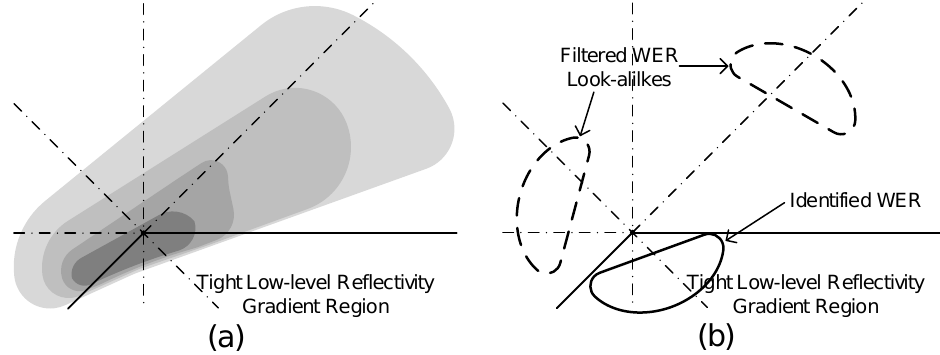
Figure 7. Schematic diagram of filtering candidate results using a tight low-level reflectivity gradient region. ( a ) Dividing the convective cell image into eight parts with equal angles. ( b ) Rule to screen candidate results. In (a), the grayscale image represents low-level echoes. In (b), the solid-line contour is the reserved results, and the dashed-line contours are filtered-out